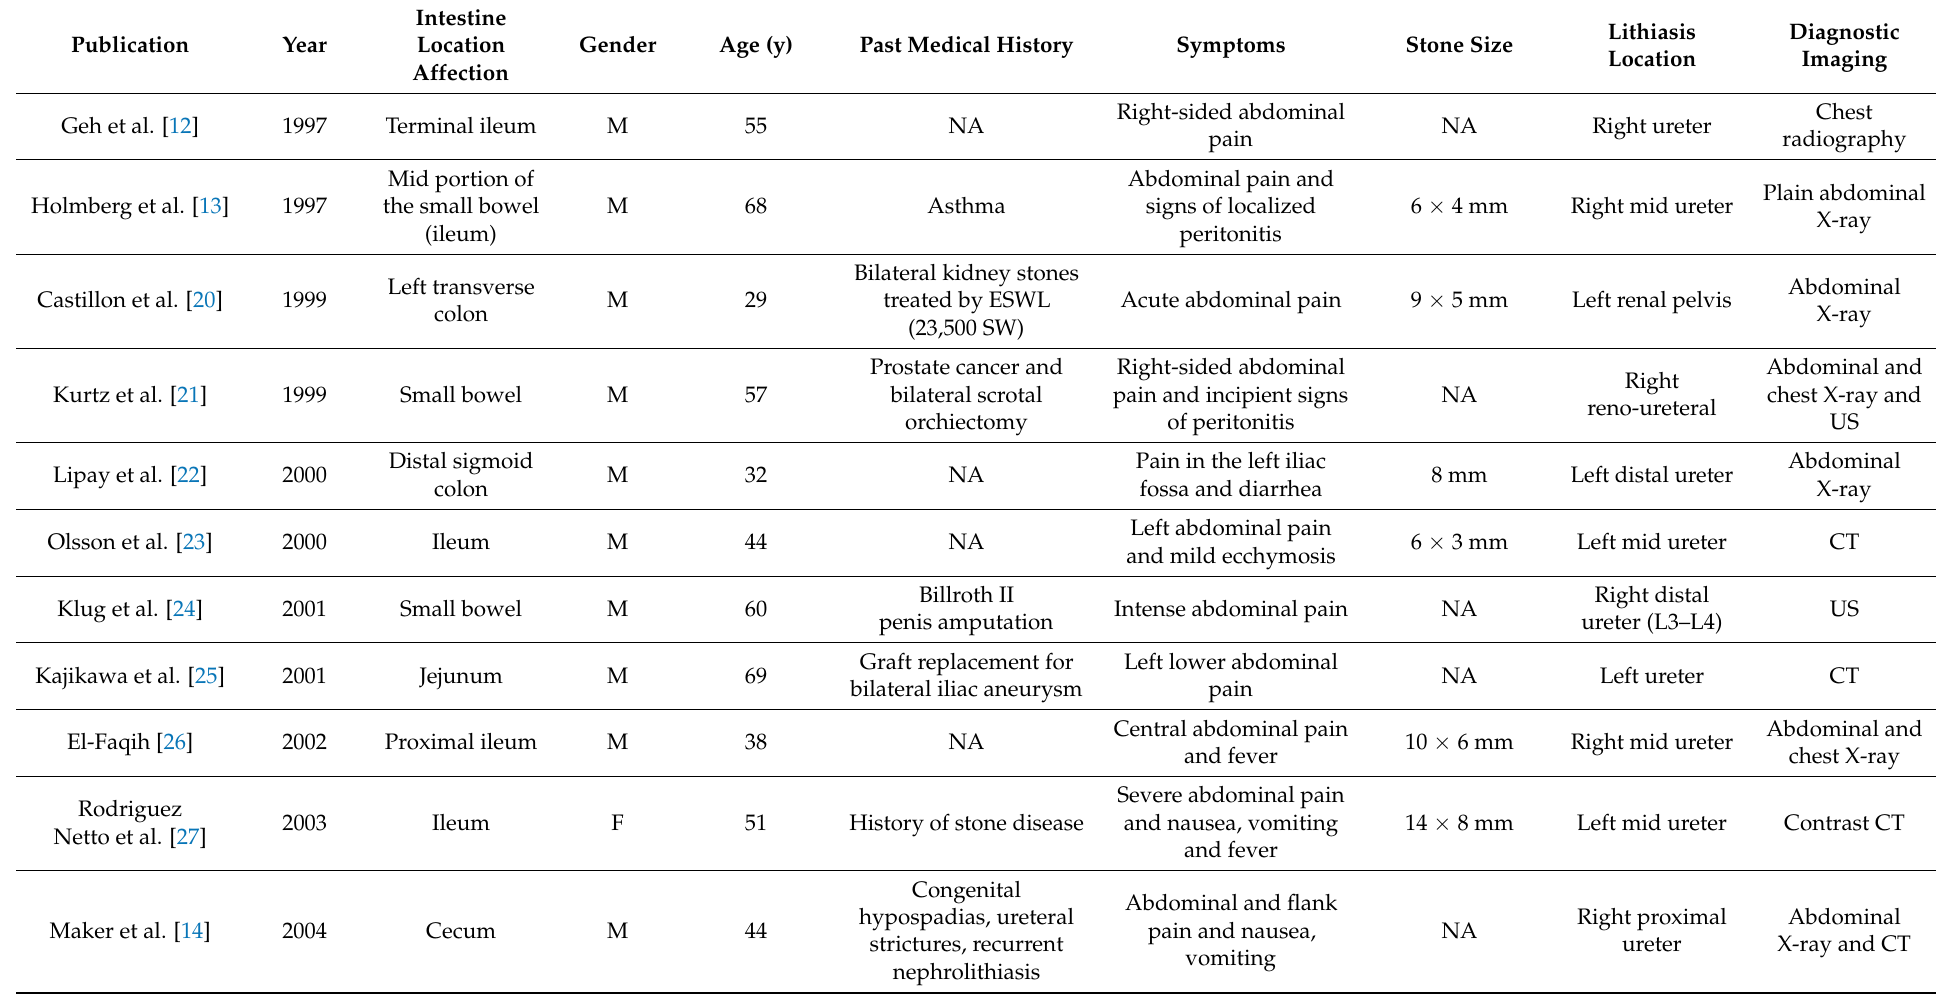
Table 1. Demographic